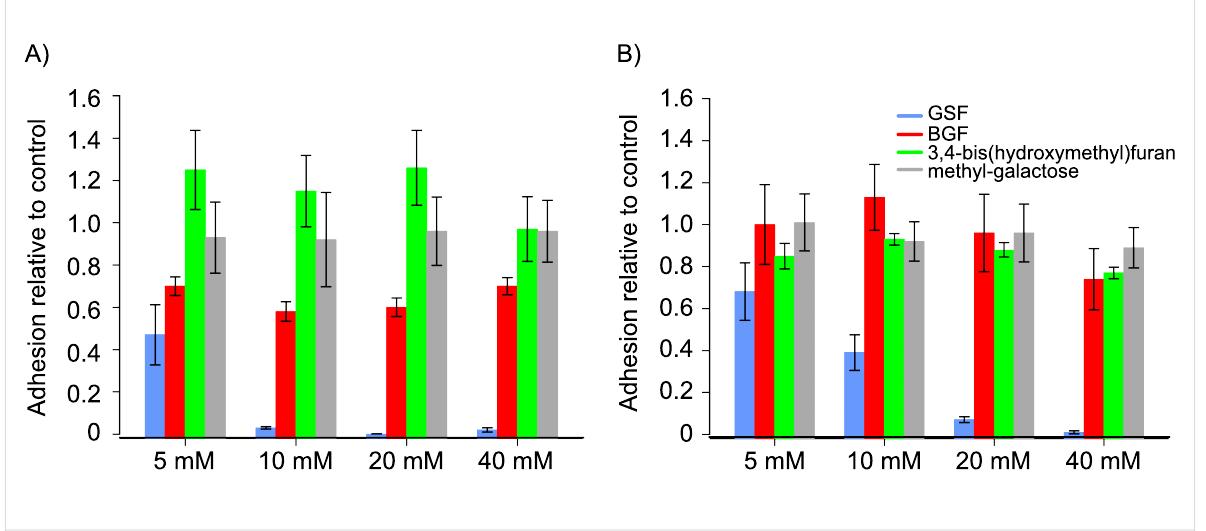
Figure 2: Inhibition of adhesion of WM-115 cells to fibrinogen (A), or to fibronectin (B) with increasing concentrations of (4-{[( β -D- galactopyranosyl)oxy]methyl}furan-3-yl)methyl hydrogen sulfate (GSF) (blue bars), 3,4-bis{[( β -D-galactopyranosyl)oxy]methyl}furan (BGF) (red bars), 3,4-bis(hydroxymethyl)furan (green bars), or methyl β -D-galactopyranoside (grey bars). Radioactively labeled cells were exposed to the compounds in medium for 1 h, then aliquots of the medium with 5 × 10 4 cells were seeded into a well precoated with the extracellular matrix protein and incubated for a further 1 h. Nonadherent cells were washed off and adherent cells quantified by liquid scintillation counting. Means of four values ± SD relative to cells adhering in the absence of the compounds are shown.